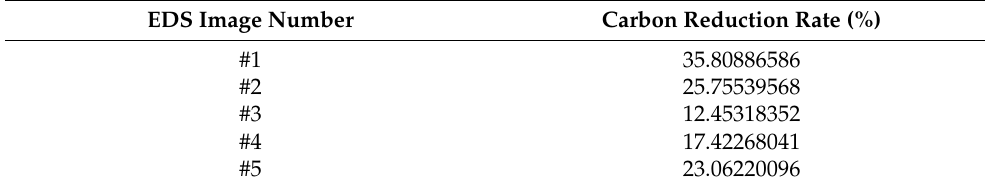
Figure 3. SEM and EDS images of CaSLA ( A – D ) and PCaSLA ( E – H ). ( I ). Carbon contents before (CaSLA) and after (PCaSLA) plasma treatment, and ( J ). calcium contents before (CaSLA) and after (PCaSLA). Carbon impurities present in the implant before plasma treatment (#). Titanium surface exposed after plasma treatment (*). Table 1. Carbon reduction rate in each EDS analysis. Carbon reduction rate was assessed by comparing the carbon content measured by EDS prior to plasma treatment (CaSLA) and after plasma treatment